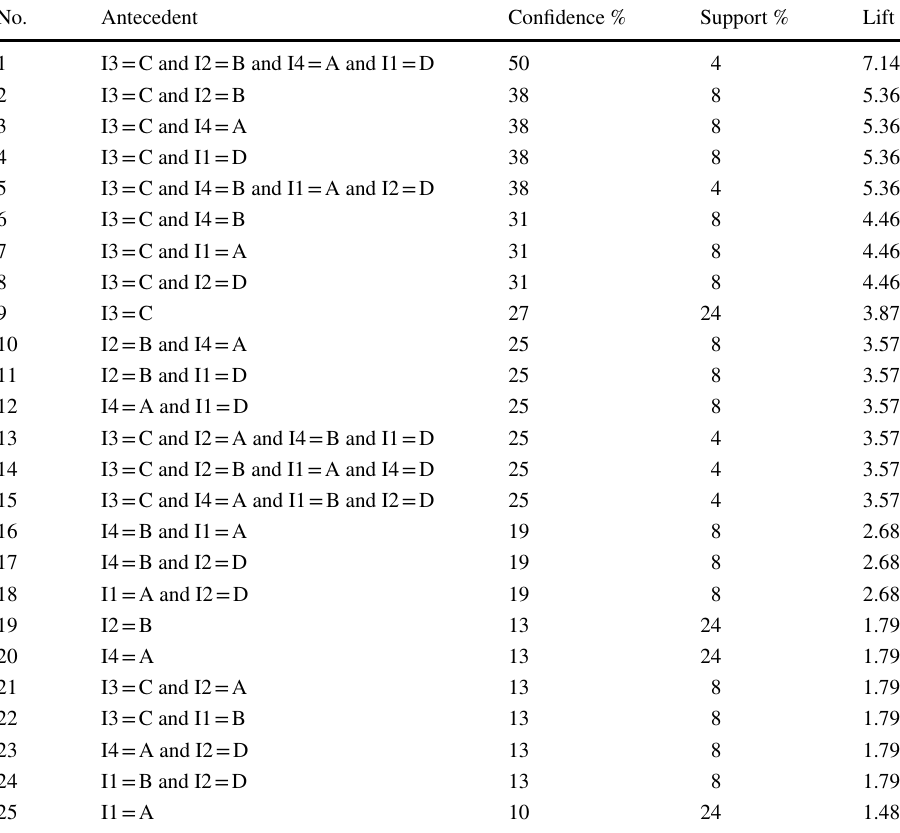
Applied Water Science (2022) 12:273